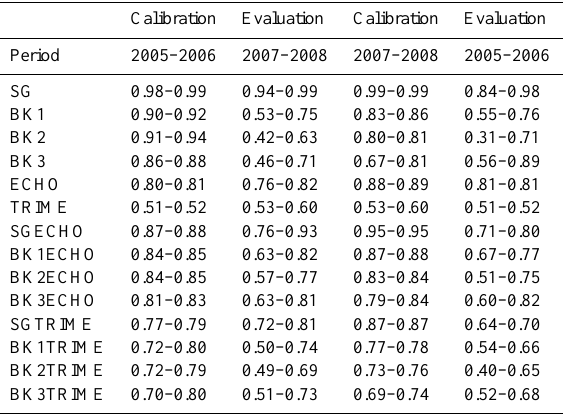
Table 4. Range of performance indices for the different calibra- tion/evaluation periods for the models calibrated against the differ- ent data sources.